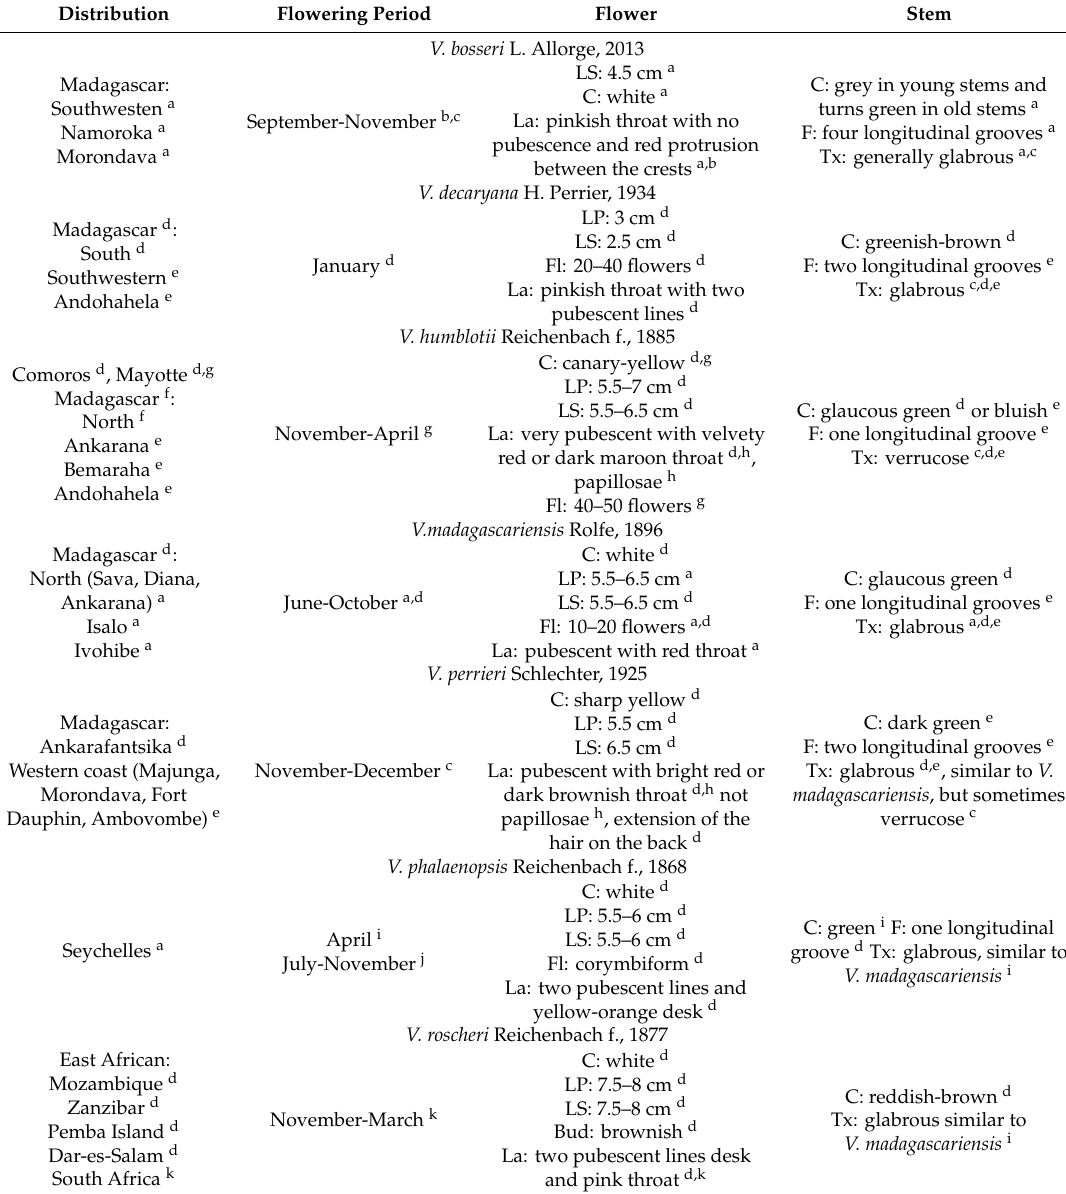
Table 4. Leafless Vanilla species from the SWIO region: geographical distribution, flowering period and morphological characteristics of the flower and stem (C: color, LP: length of petal, LS: length of sepal, La: labellum, Fl: inflorescence, F: form, Tx: